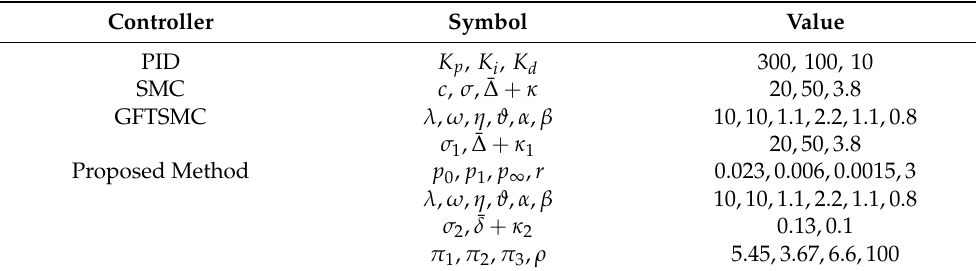
Table 2. The control